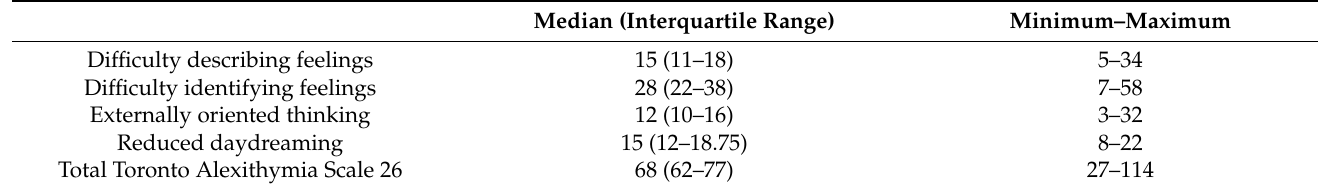
Table 1. Values of the Toronto Alexithymia Scale 26.